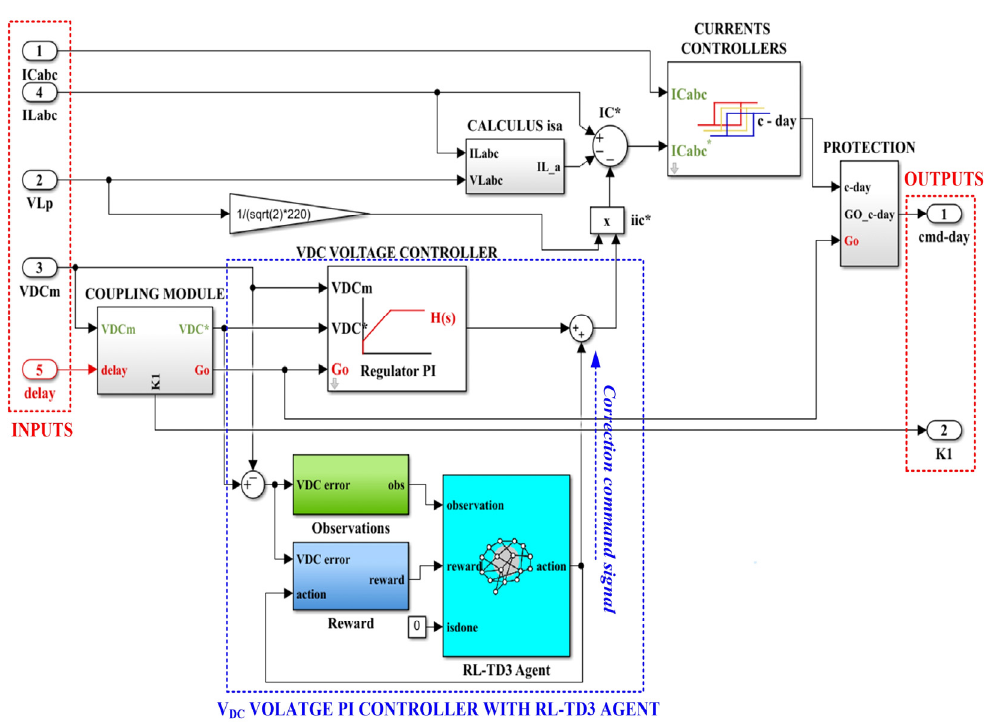
Figure 6. Block diagram subsystem implementation in MATLAB/Simulink of the APF control system based on PI controller with RL-TD3 agent.